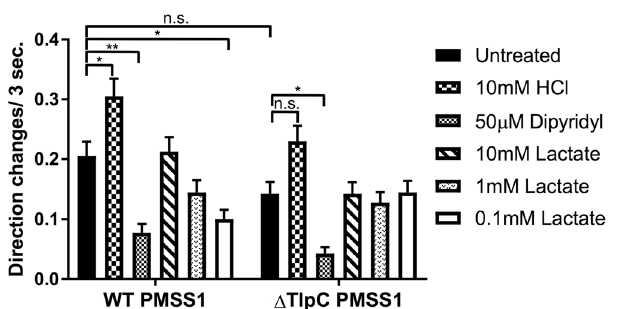
Figure 7. Lactate triggers a TlpC-dependent attractant response in H . pylori . Cultures of isogenic wild-type (WT) and Δ tlpC ( ∆ TlpC) H . pylori PMSS1 were grown in BB10 overnight, treated with various concentrations of sodium L- lactate or control compounds as indicated, and then immediately filmed. Direction changes were enumerated over a 3 second period in at least 200 cells per treatment in two biological replicates. 10 mM HCl or 50 μ M dipyridyl serve as known repellent and attractant response controls, respectively. Error bars represent the standard error of the mean. * p < 0.05; ** p < 0.01, comparisons performed using a two-way ANOVA, followed by Tukey’s pairwise comparisons ( α = 0.05). There were no significant differences in the basal behaviour between wild type and its tlpC